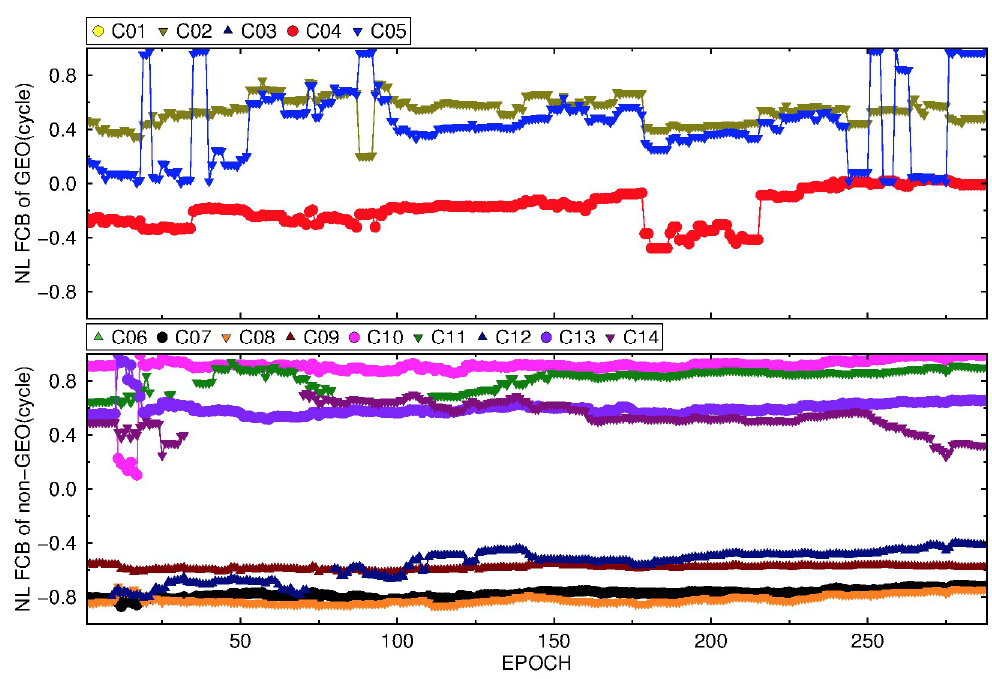
Figure 14. The variation of BDS NL FCB by the new strategy on DOY 083, 2018.